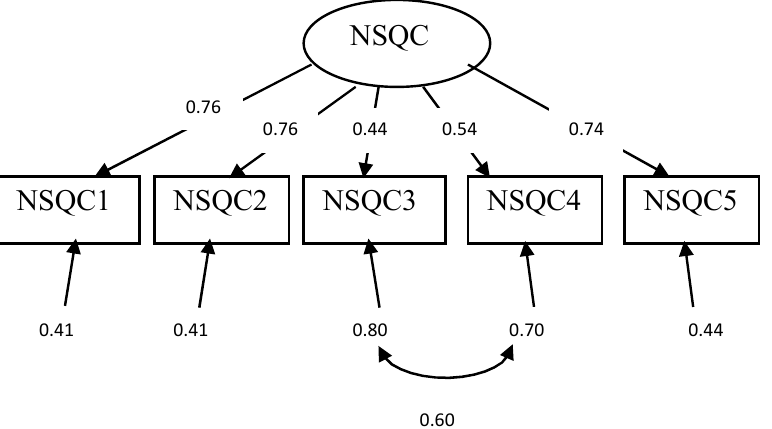
Figure 2. The standardized observed variables loadings model. NSQC, Nurse Satisfaction with Quality of Care. Note: all coefficients were statistically significant ( p < 0.001). Table 3. Correlation matrix between observed variables. Observed